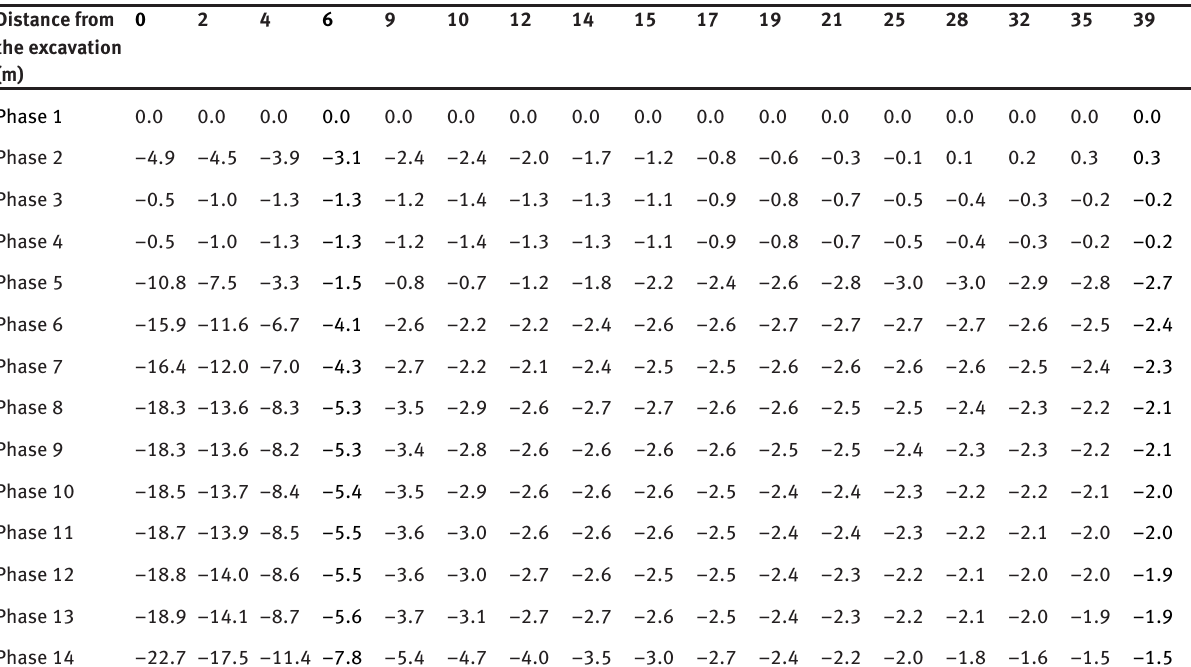
Table 3: The juxtaposition of the vertical displacement values in [mm] of the land surface. from the 3D numerical model in the analyzed implementation phases. for the right side of the A–A test